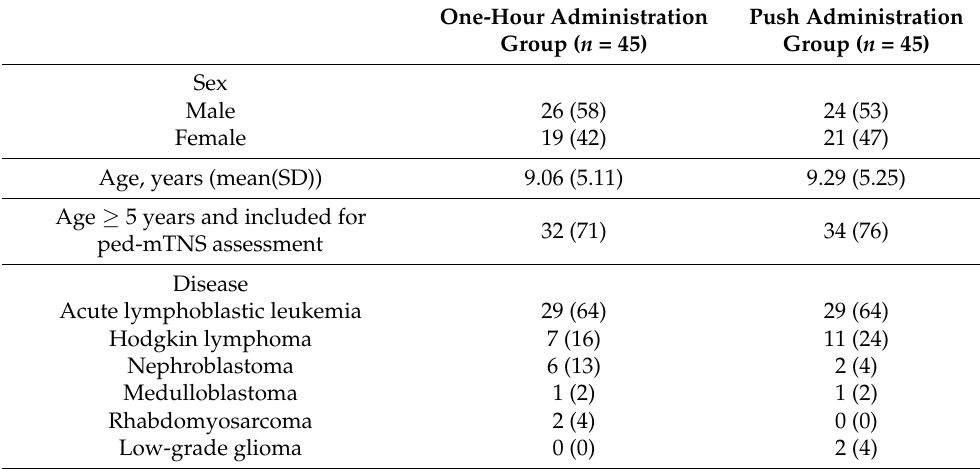
Table 1. Demographic and clinical characteristics of the participants at